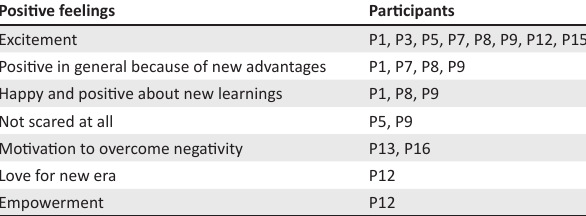
TABLE 3: Positive feelings towards the fourth industrial